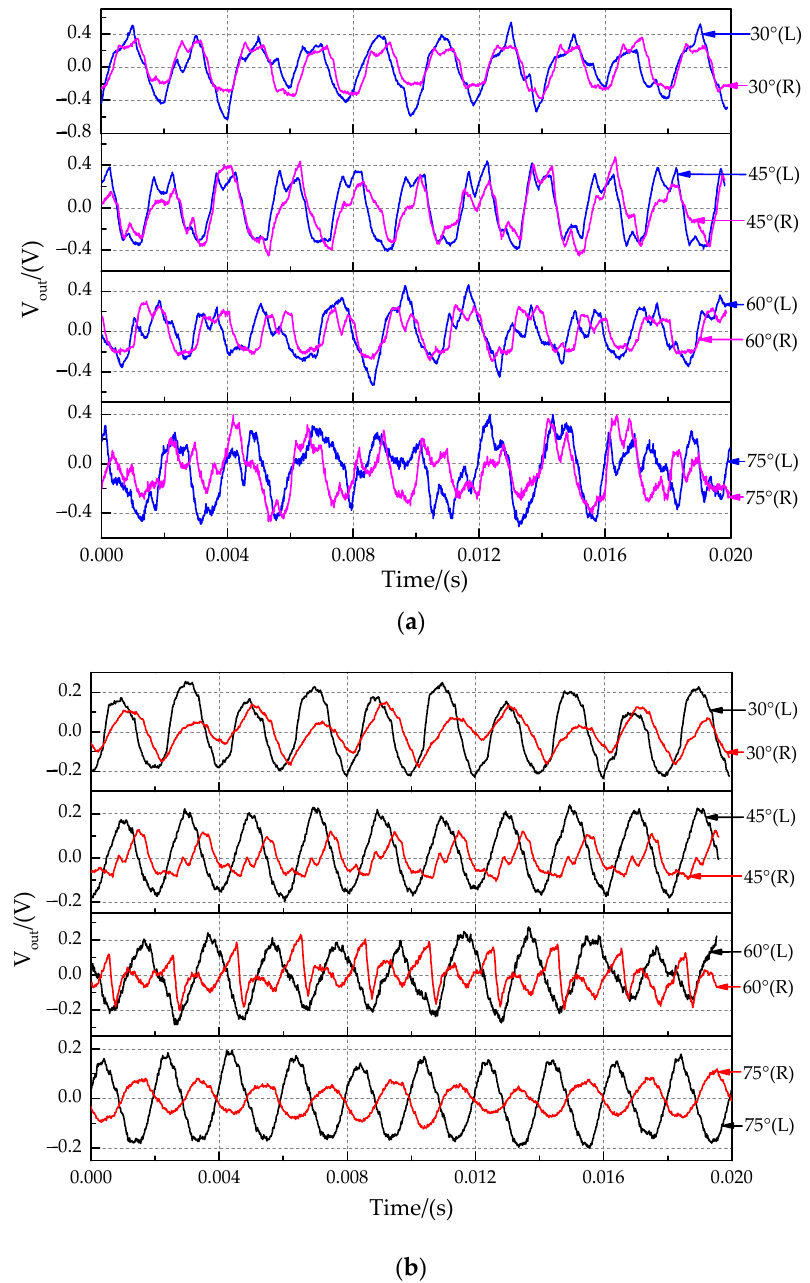
Figure 16. Time-domain characteristics of output signals at the sound source incident angle of 30°, 45°, 60° and 75°. ( a ) Non-coupling structure. ( b ) Coupling structure.